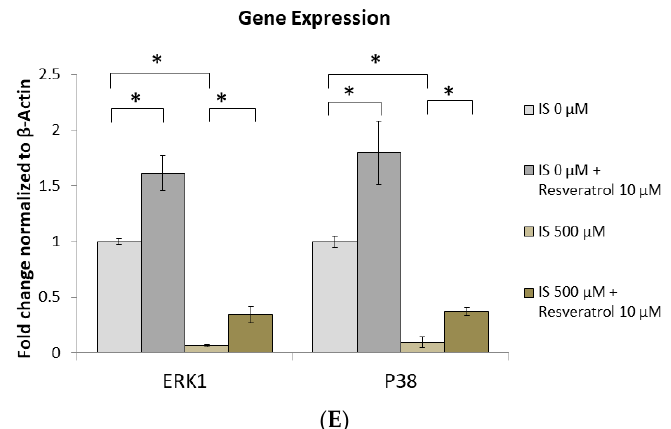
Figure 4. IS inhibits the phosphorylation of ERK and p38 MAPK. MC3T3 E1 cells were cultured in an osteogenesis medium with IS at 0, 100, 500, and 1000 μ M with or without RSV for 2 h. ( A – D ) In whole cells, the phosphorylation of ERK1/2 and p38 decreased in a dose-dependent manner with the concentration of IS. At 500 and 1000 μ M IS, ERK1/2 and p38 MAPK phosphorylation was significantly suppressed in comparison to the control group. RSV significantly alleviated ERK1/2 phosphorylation at 500 and 1000 μ M IS. ( E ) At 500 μ M IS, the expression of ERK1 and p38 genes was significantly reduced compared to their levels in the control group. When RSV is also added, the expression of ERK1 and p38 genes is significantly increased in response to IS treatment at 0 and 500 μ M. Data are represented as the mean ± SEM ( n = 3). * Indicates differences that were considered significant between the indicated groups ( p < 0.05).